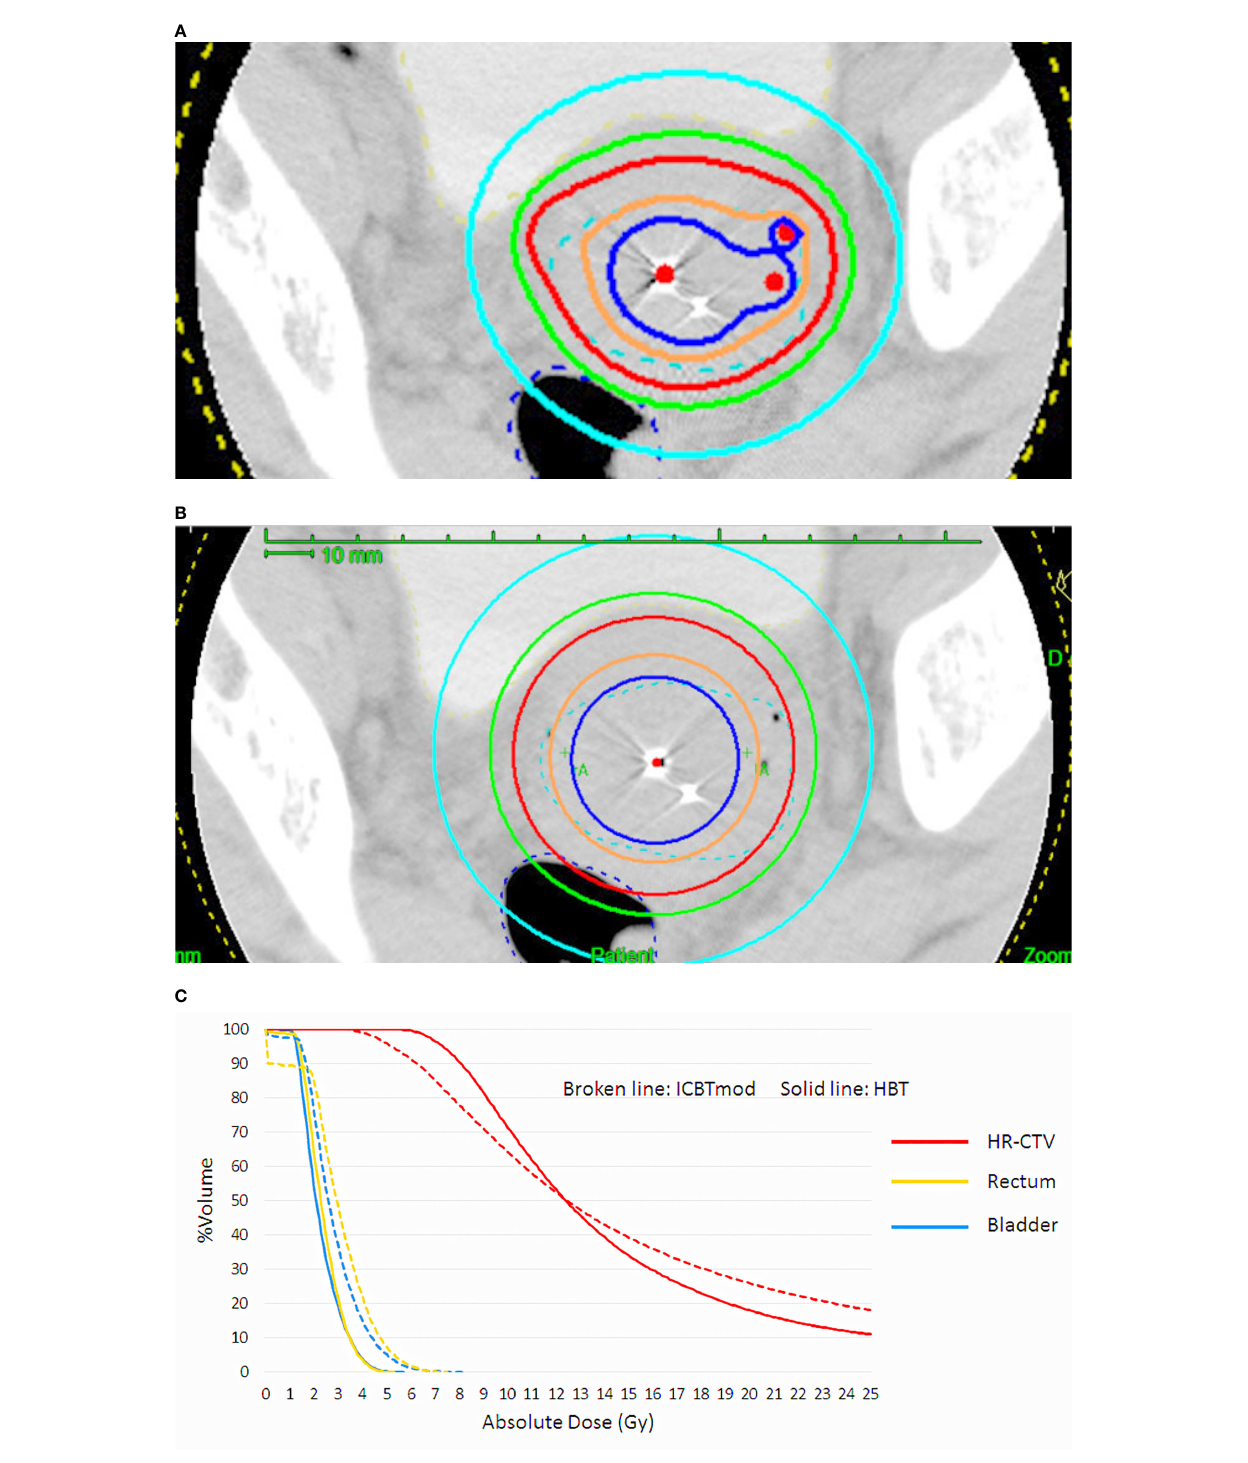
FIGURE 1 | (A) Dose distribution of hybrid brachytherapy (HBT) and (B) dose distribution of intracavitary irradiation with increasing dwell times of ovoid applicator (ICBTmod) to cover high-risk CTV with D90 ≥ 6 Gy. (C) Dose-volume histogram (DVH) shows increased rectal and bladder doses in ICBTmod. HBT can deliver an adequate high-risk CTV dose without increment of rectal and bladder